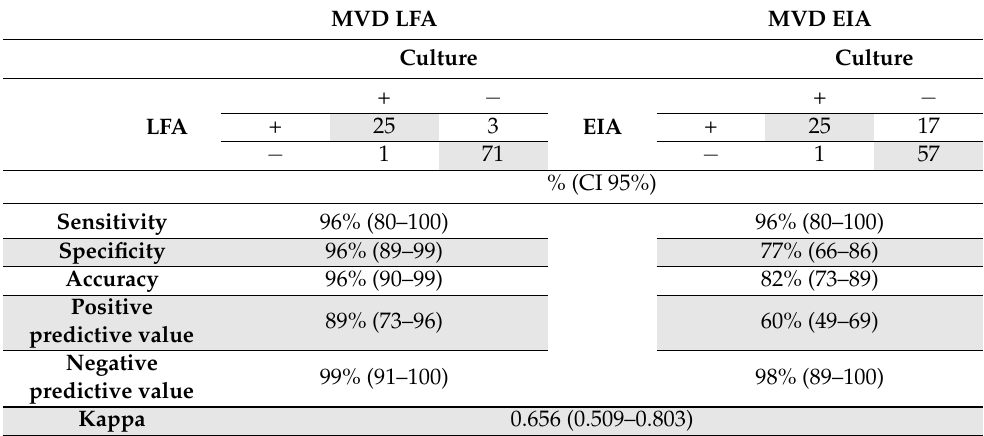
Table 1. Analytical performance of the MVD Histoplasma urinary Ag LFA and MVD EIA. MVD LFA MVD EIA Culture Culture + − + − + 25 3 + 25 LFA EIA